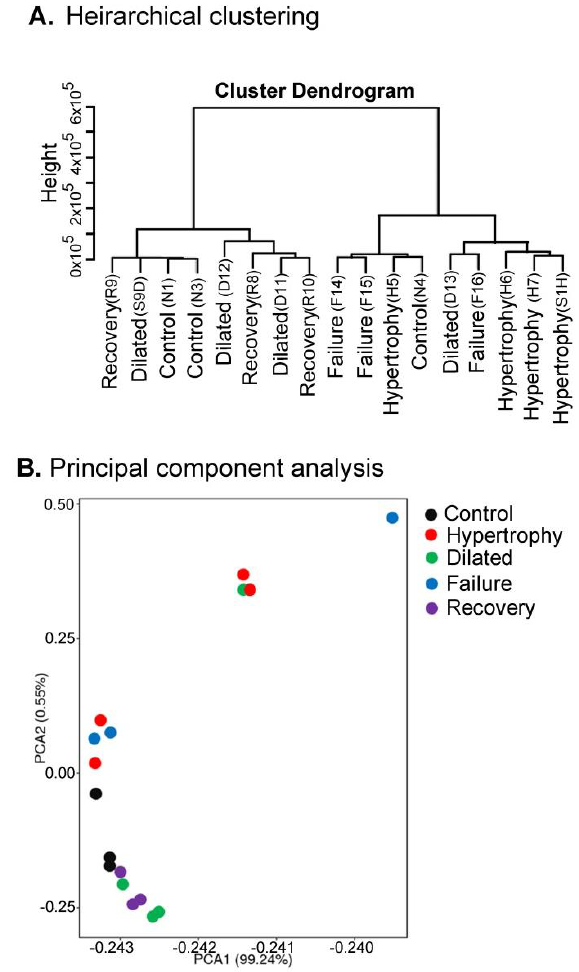
Figure 1. Hierarchical clustering and principal components analysis of gene expression. ( A ) The dendrogram shows hierarchical clustering of all samples according to their gene expression. The closeness of any two samples in the dendrogram shows that samples are similar in their gene expression. ( B ) The principal component analysis shows the samples plotted according to differential gene expression. The distance between points approximates differences in gene expression among samples.